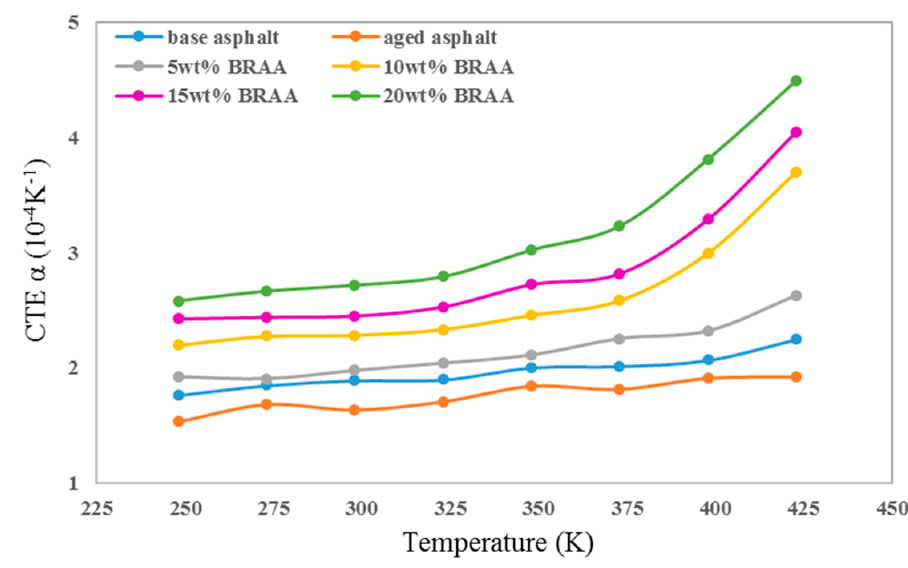
Figure 4. Thermal expansion coefficients of asphalt systems.